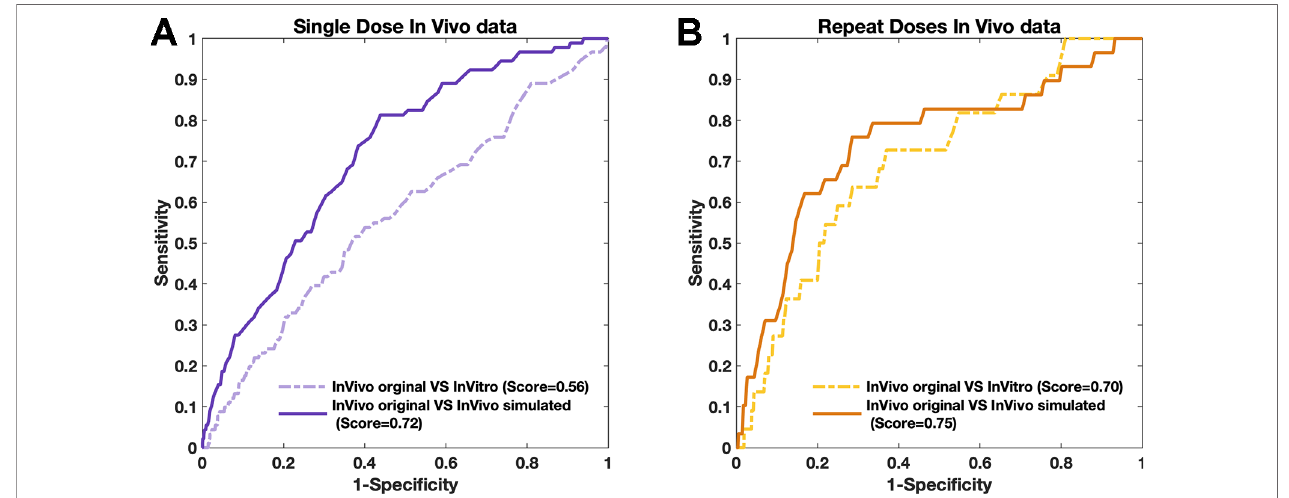
FIGURE 5 | The similarities of simulated data with real in vivo data obtained by PRank score. (A and B) The consistencies obtained by single-dose data (purple) and repeat-doses data (yellow),